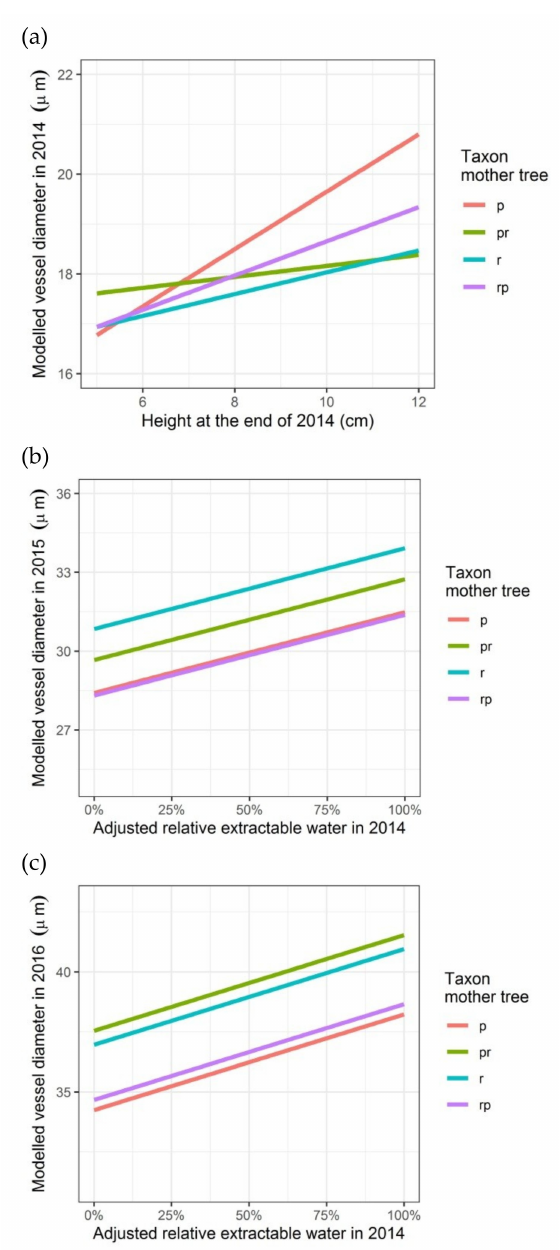
Figure 4. Modelled vessel diameter depending on the height of the seedlings (2014) or on the relative growth rate in height (2015), on the adjusted relative extractable water in 2014 (latewood vessel diameters in rings of 2015 and 2016) and on the taxon of the mother trees (latewood vessel diameters in rings of 2014, 2015 and 2016): ( a ) first growing season 2014; ( b ) second growing season 2015; ( c ) third growing season 2016. p: Q. petraea , pr: long stalked intermediate form, r: Q. robur , rp: short-stalked intermediate